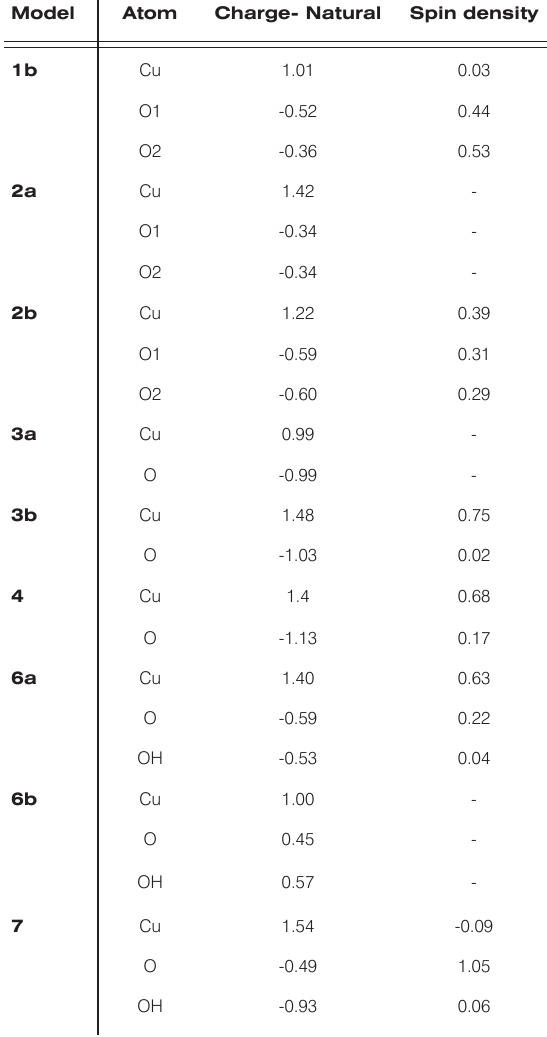
Table 4. Natural population analysis for the structures 1b - 7 .